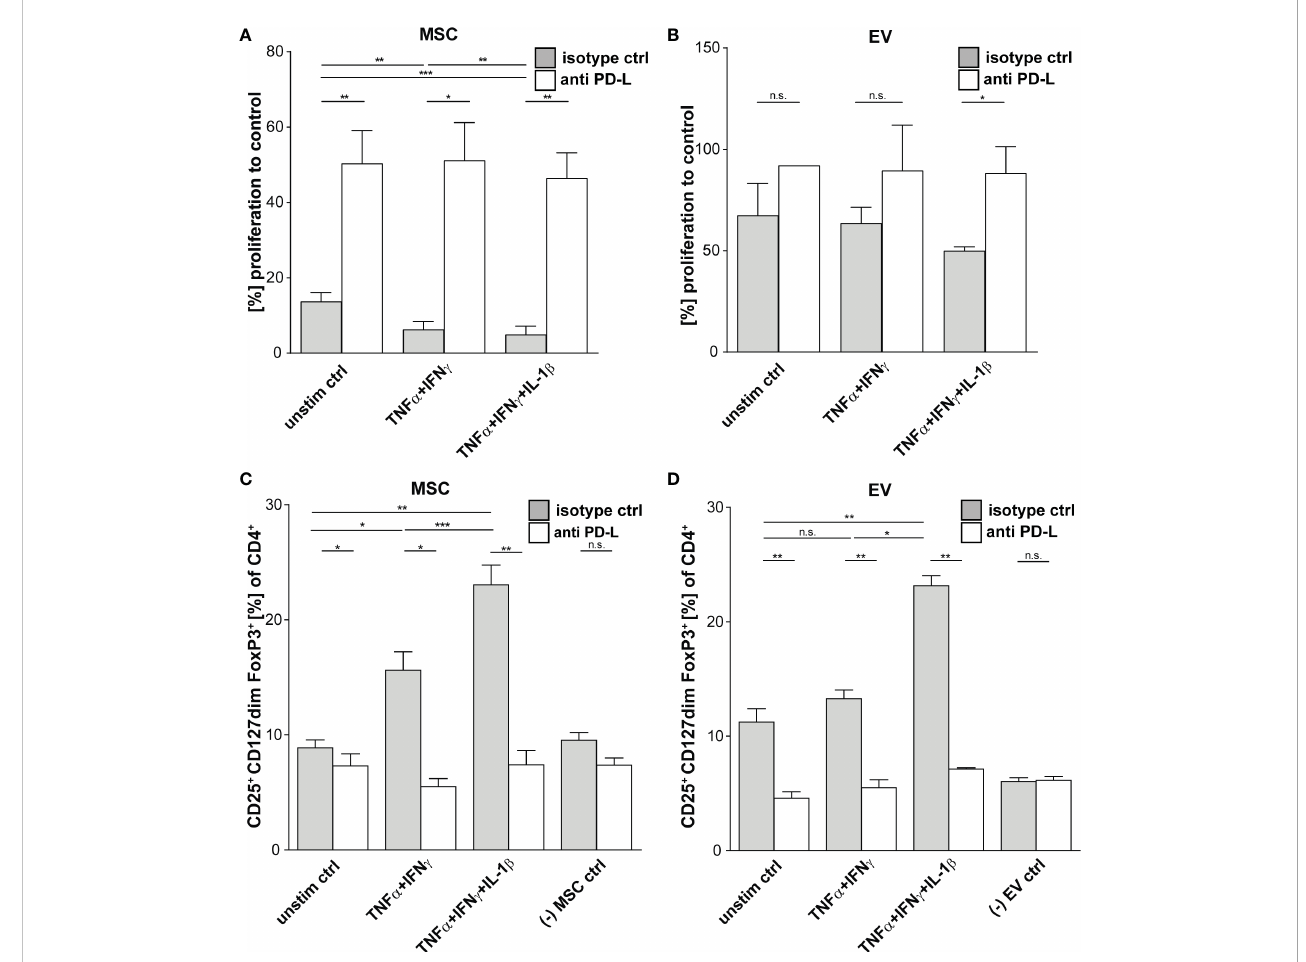
FIGURE 3 Suppression of CD3 + T Cells by primed MSCs/MSC-EVs is mediated by PD-1 Ligands. CD3 + isolated from healthy donors were incubated with MSCs/ MSC-EVs primed by TNF a and IFN g or by TNF a and IFN g in combination with IL-1 b and with inhibitory antibodies against PD-L1 (2µg/ml) and PD-L2 (2µg/ml) or isotype control (mIgG1/2a). (A, B) CD3 + proliferation measured via proliferation dye by fl ow cytometry. CD3 + T cells cultured with (A) primed MSC or (B) MSC-EVs. (C, D) Tregs were determined with MFI marker expression of CD4 + CD127 dim CD25 + FOXP3 + of total CD4 + by fl ow cytometry. CD3 + T cells were cultured with (C) MSCs or (D) incubated with MSC-EVs. Paired t-test was used to test statistical signi fi cance (p < 0.05 considered as signi fi cant), MSC, n = 3. Data are shown as center value: mean; error bars: SD. ns, not signi fi